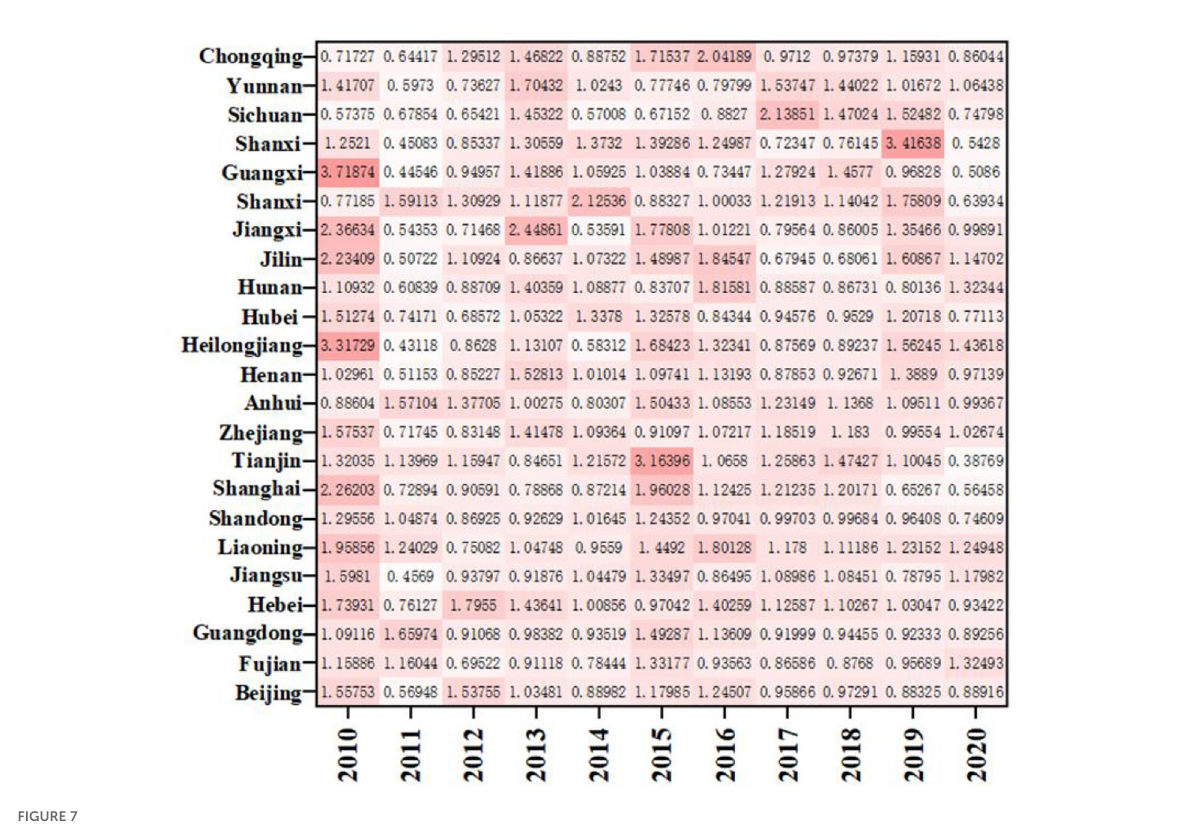
Class C are regions with high ERDS and low EETS. The 23 provinces studied in this paper are not included in such